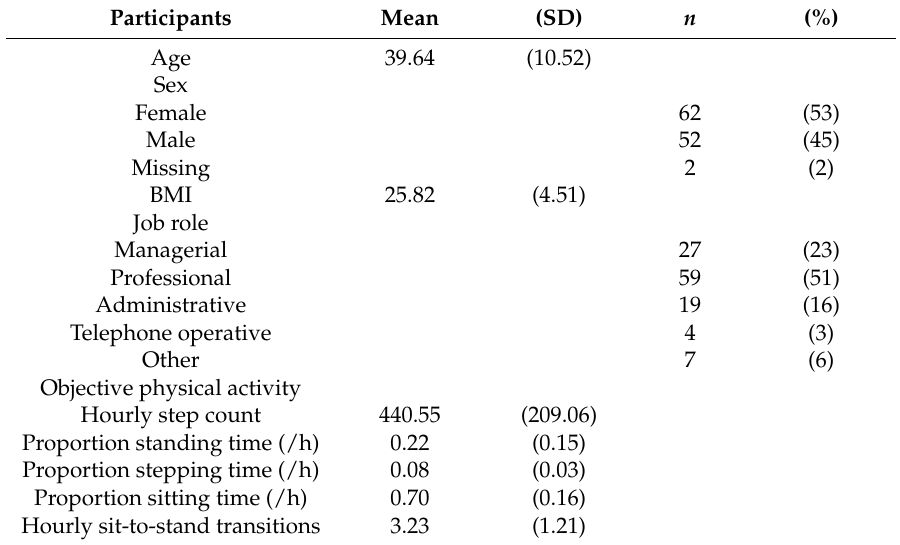
Table 1. Participant characteristics, objective physical activity levels and habit scores ( n =